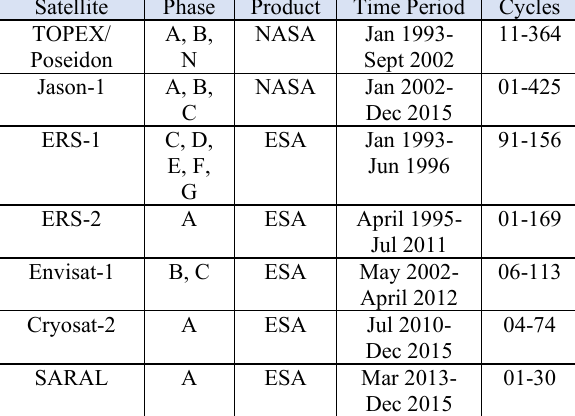
Table 1. Selected multi-mission satellites with time period data In RADS processing, there are several steps to retrieve SLA data.